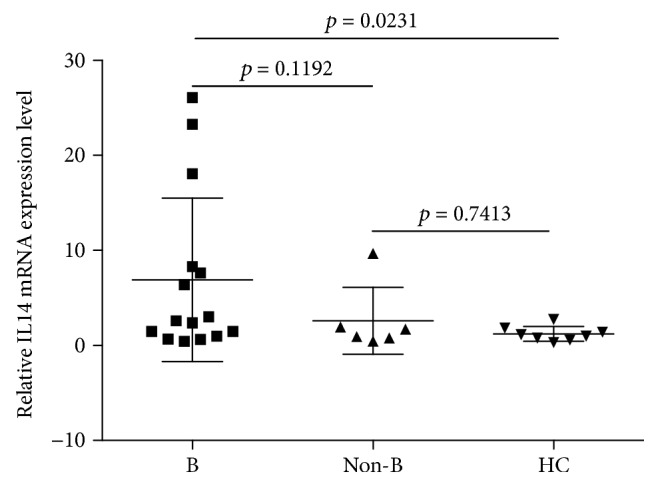
IL14α expression of IL14α in peripheral blood leukocytes of B cell lymphoma patients, non-B cell lymphoma patients, and HC.